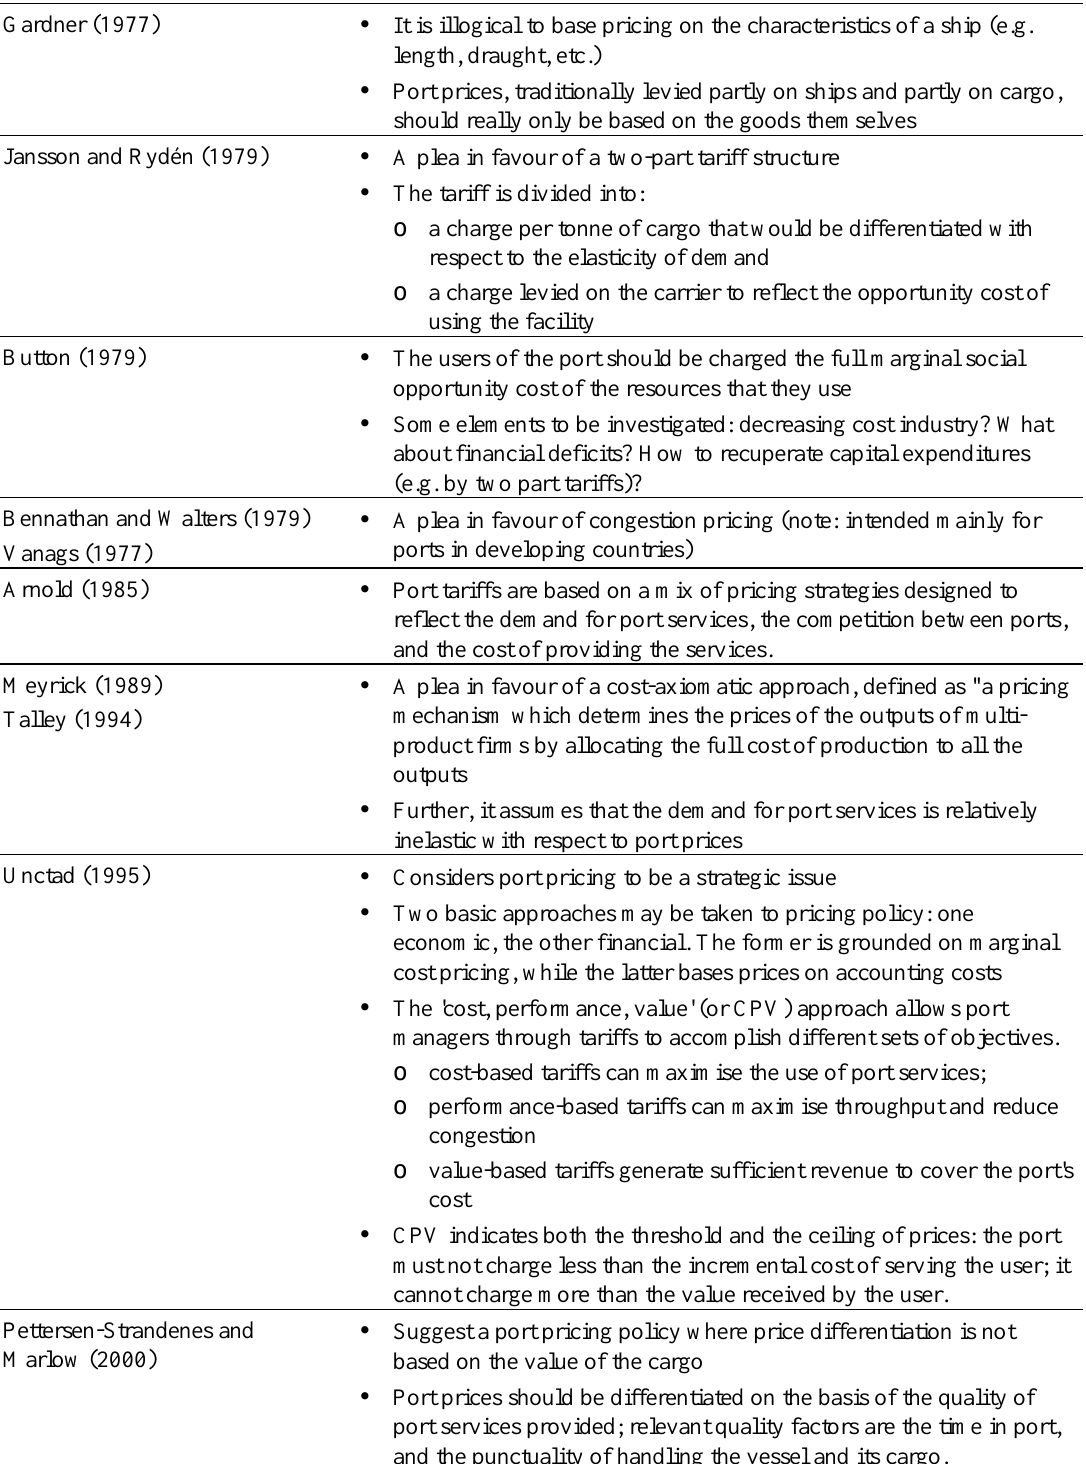
Table 2. Pricing concepts and